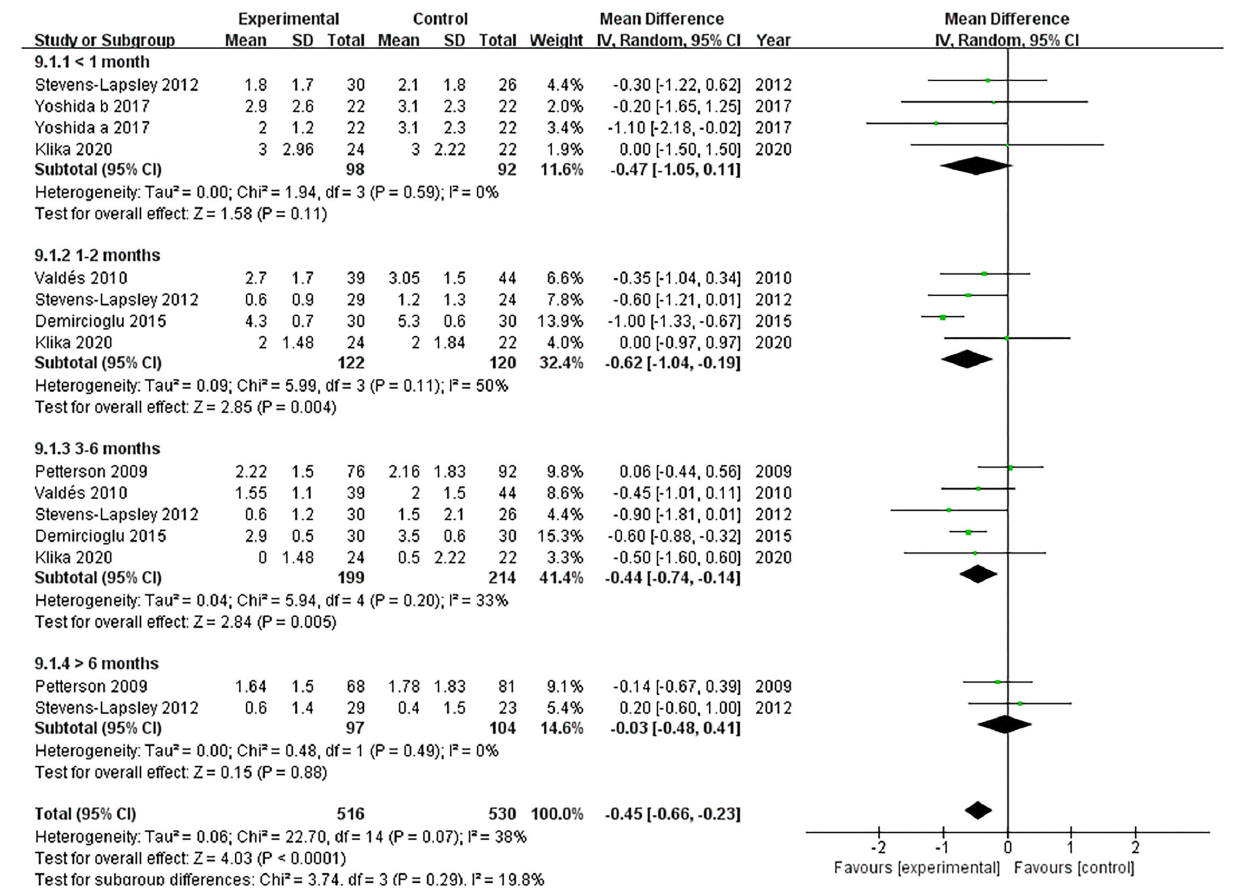
FIGURE 6 | Forest plots of meta-analysis of the effect of NMES vs. conventional rehabilitation on pain.